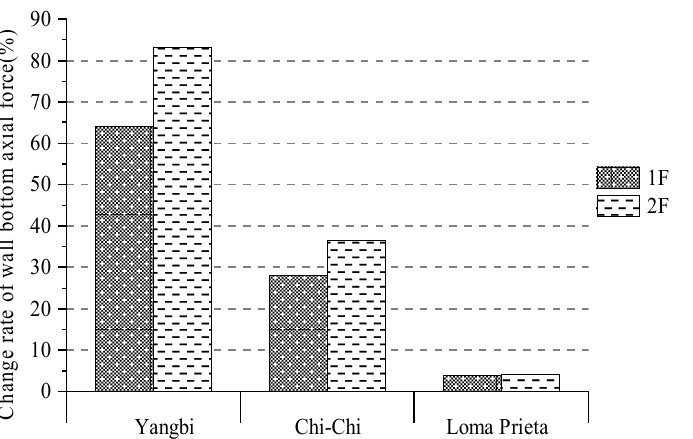
Figure 11. The change rates of maximum axial force of brick masonry walls bottom of each layer.